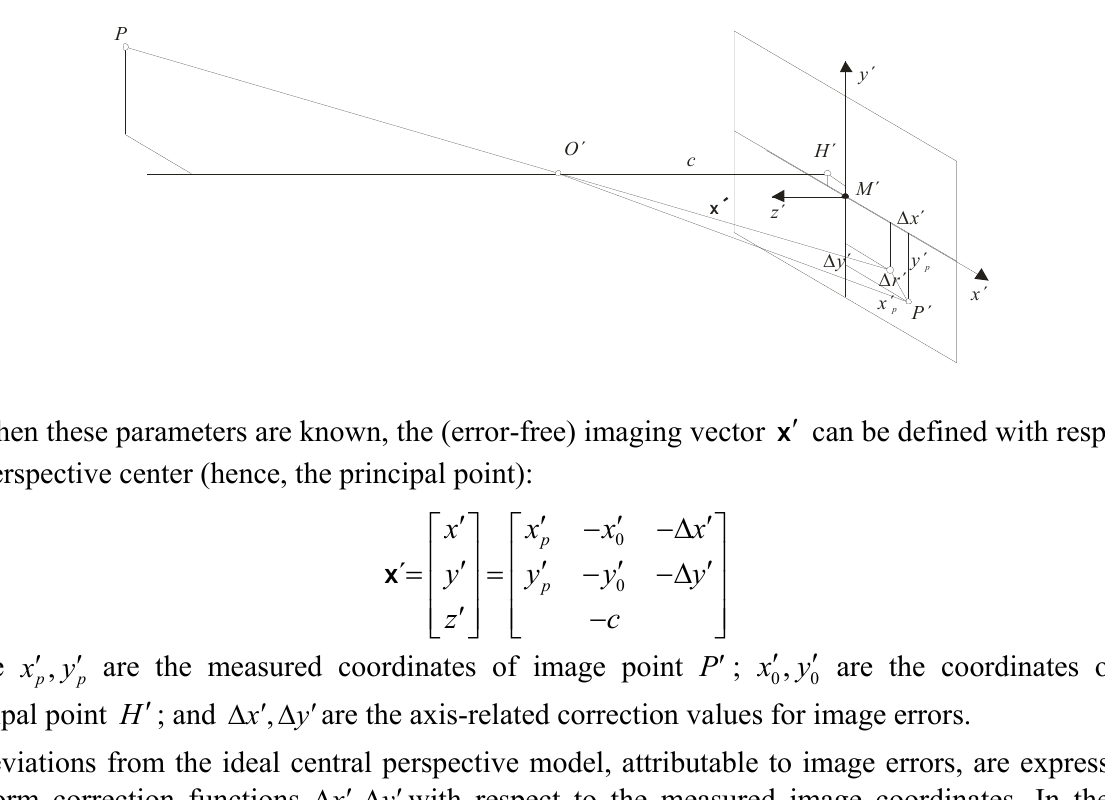
Figure 1. Interior orientation parameters